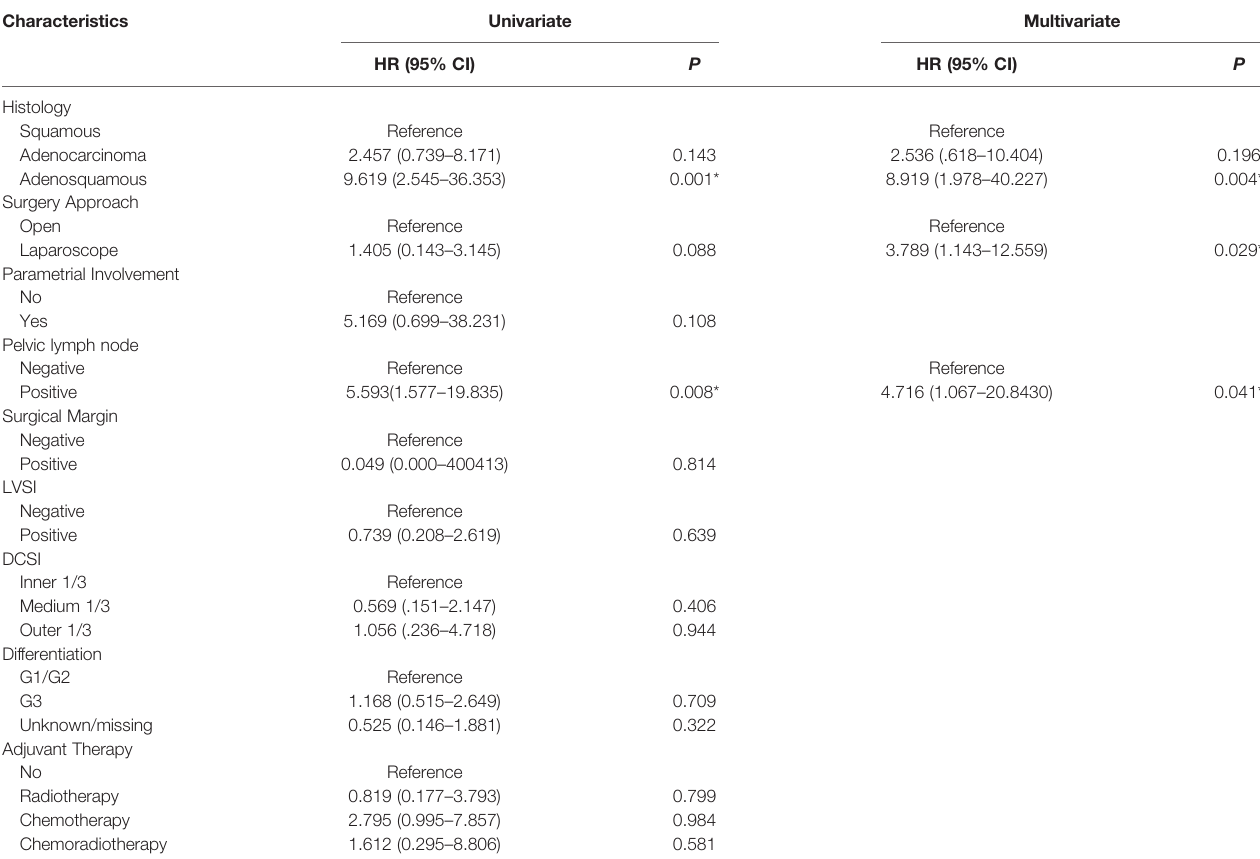
TABLE 2 | Factors Associated with Recurrence-Free